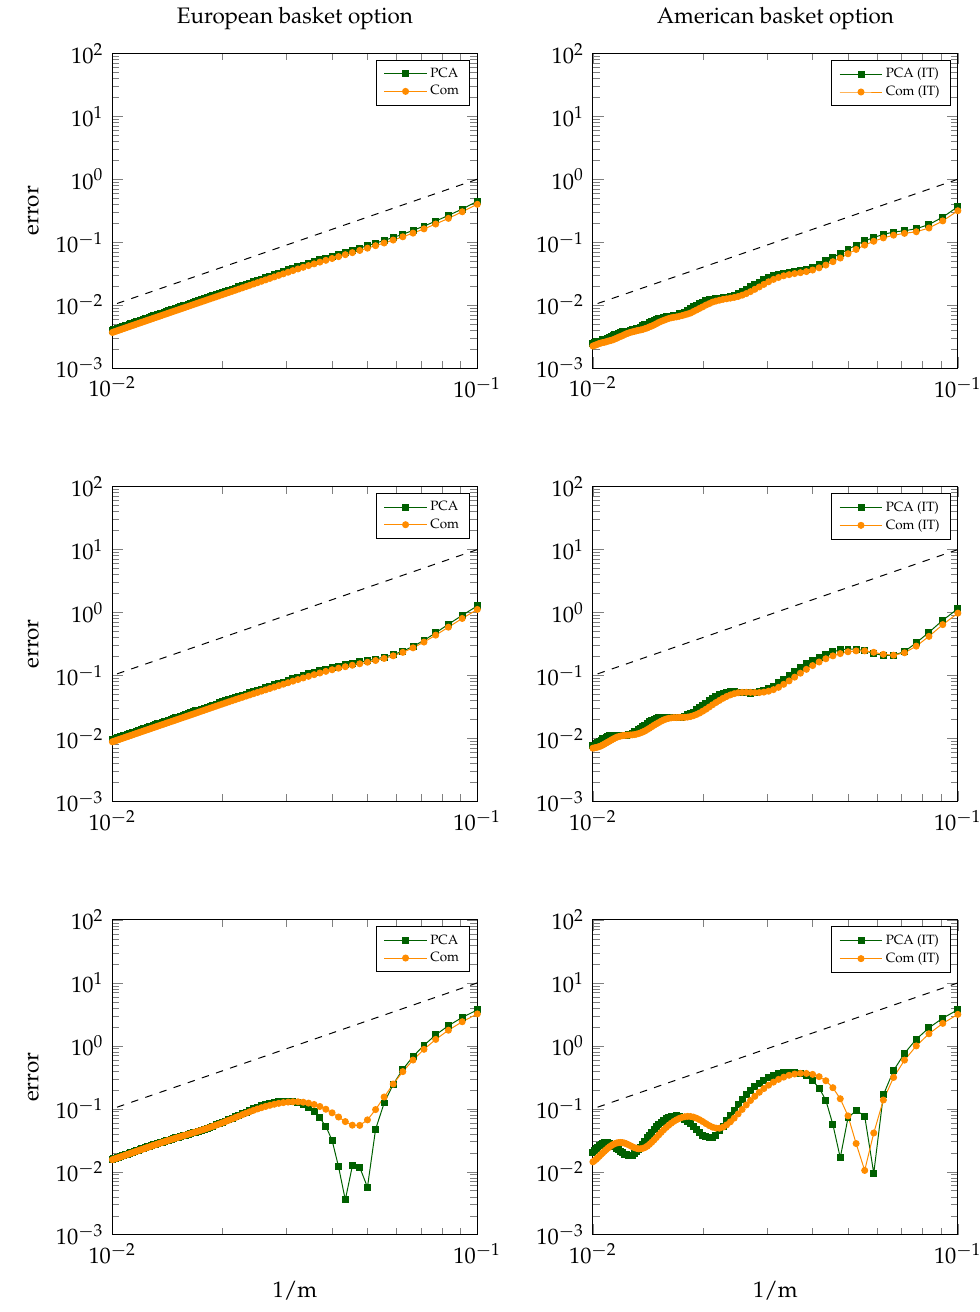
Figure 4. Discretisation error for r u p S 0 , T q and u app p S 0 , T q in cases T “ 0.5 ( top ), T “ 1 ( middle ) and T “ 2 ( bottom ) where K “ 40, σ 1 “ 0.3. Left : European basket option. Right : American basket option. Reference line (dashed) included for second-order